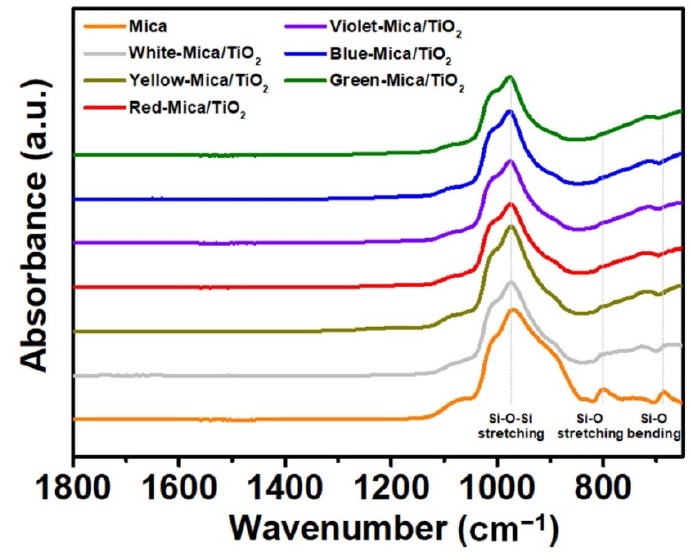
Figure 5. FT-IR spectra of mica and color mica/TiO 2 materials.